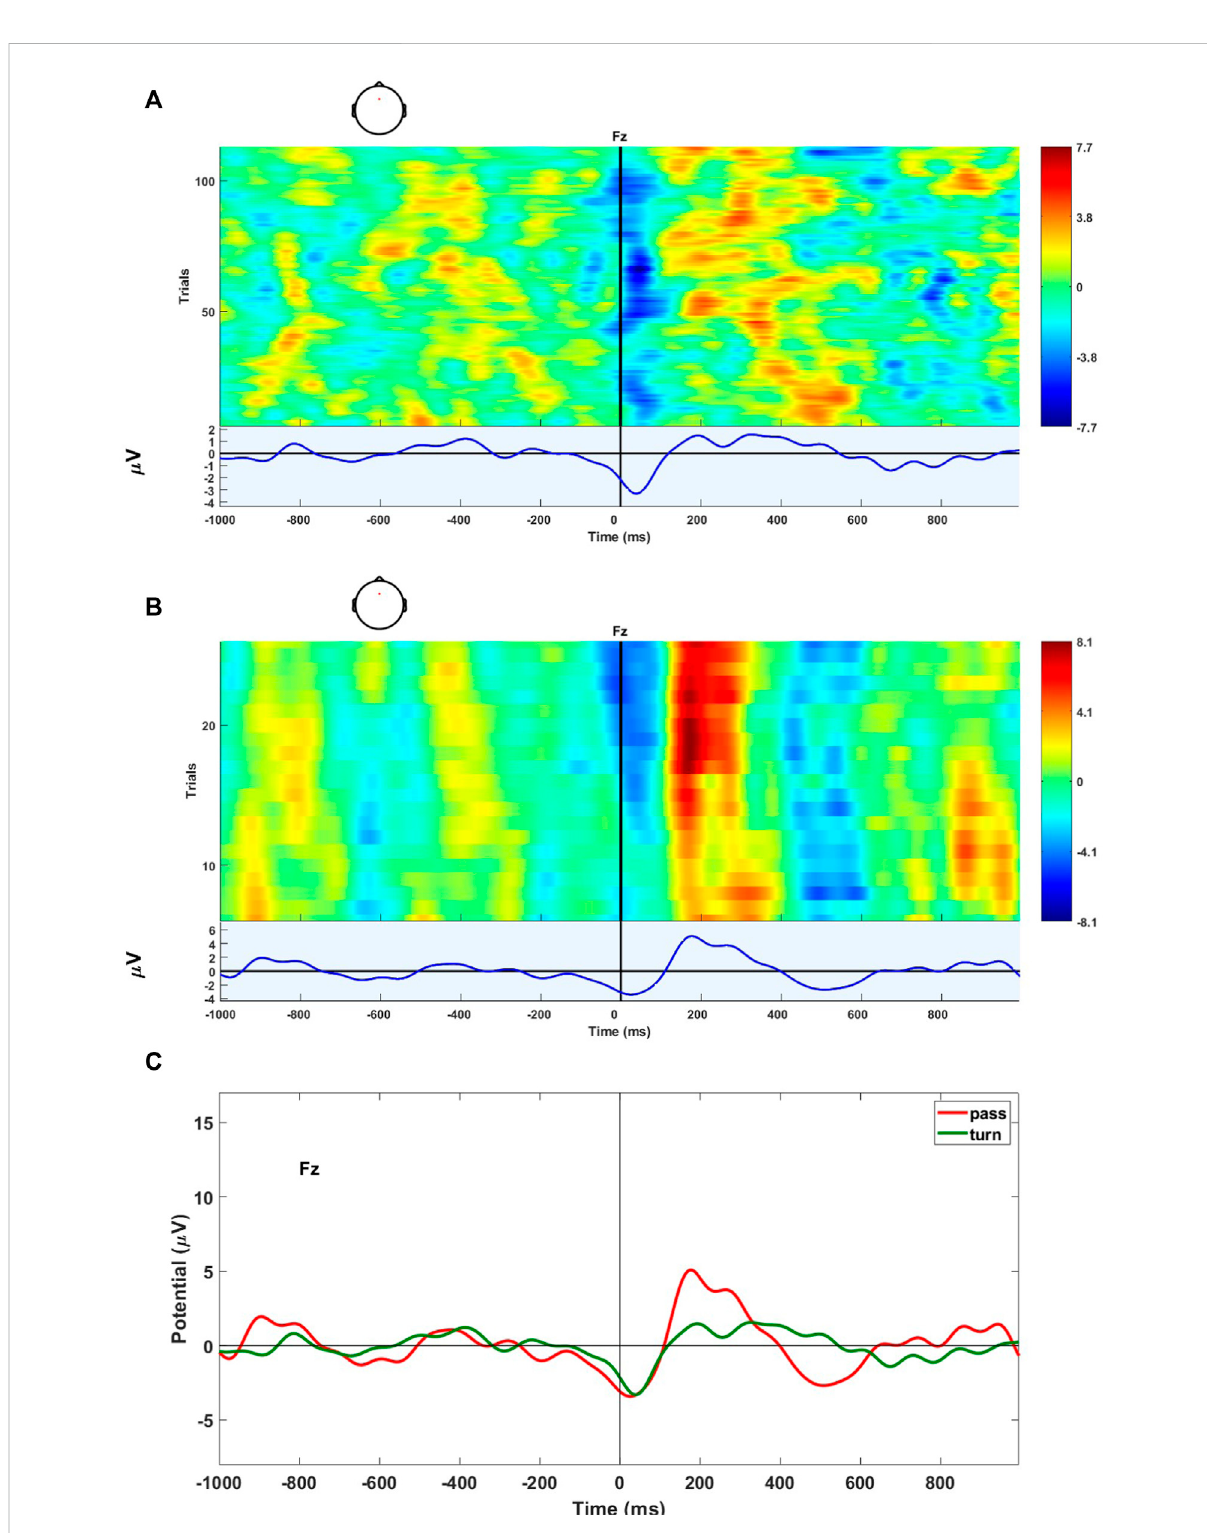
FIGURE 8 ERPs of subject S002. (A) Fz channel for the “ Turn ” group (i.e., the robot successfully avoid the obstacles). (B) Fz channel for the “ Pass ” group (i.e., the robot failed to avoid the obstacles). (C) Grand average over the Fz channel for two conditions, “ Pass ” and “ Turn ”